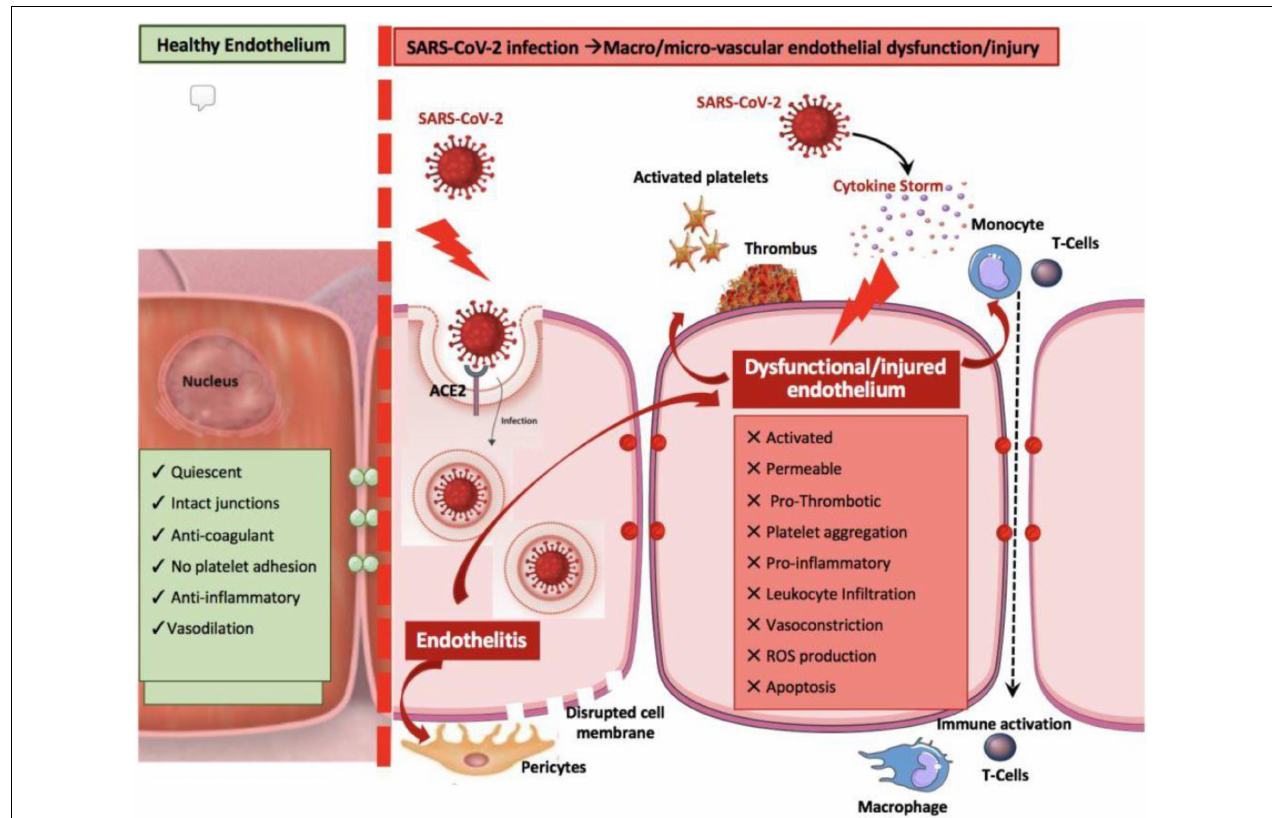
FIGURE 2 | Possible mechanisms of coronary endothelial dysfunction in COVID-19 (31). ACE2, angiotensin-converting enzyme 2. Source: Evans et al. (31). Used with permission.